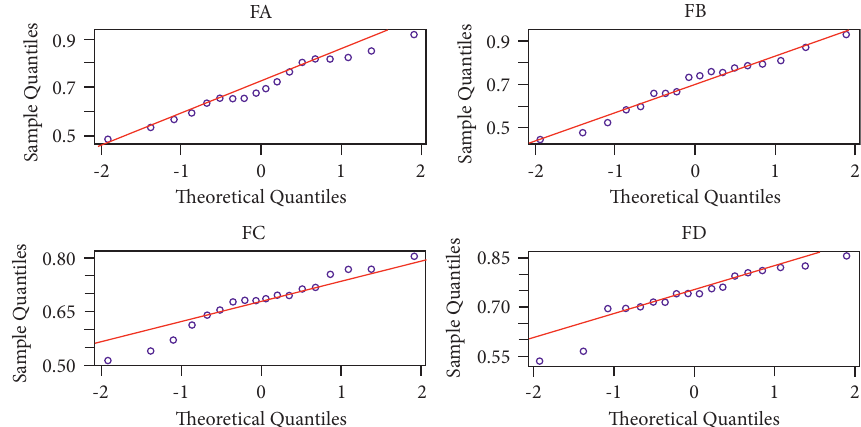
Figure 7: QQ chart of comprehensive risk evaluation score of each dimension and overall financial risk evaluation score.